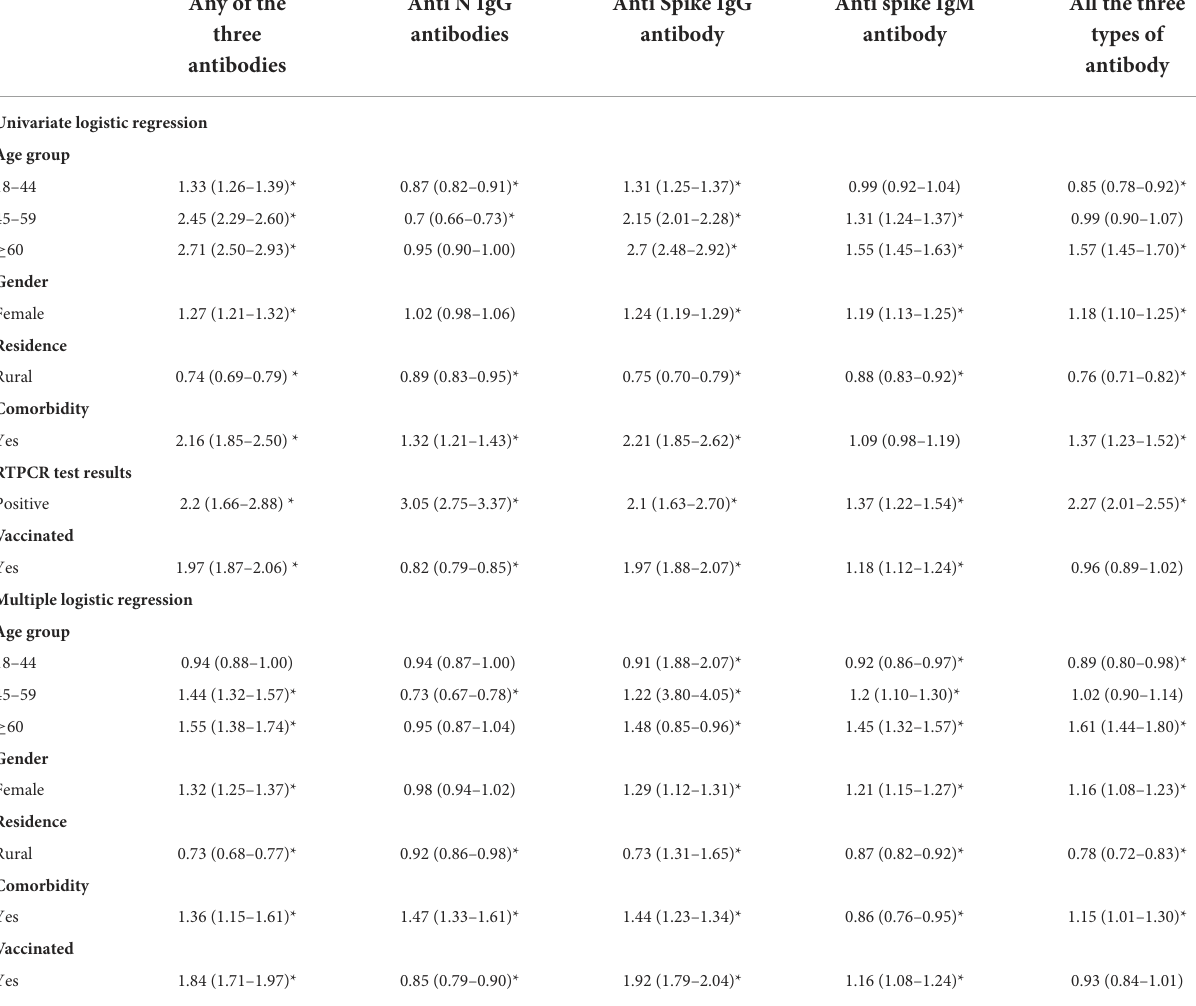
TABLE 6 Logistic regression analysis of the